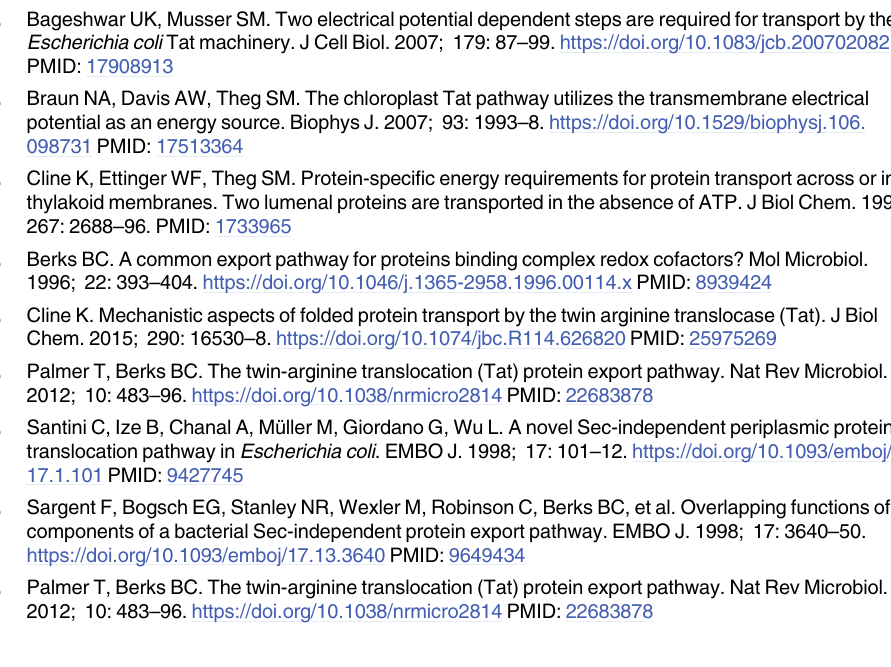
S1 Fig. Protein sequences for the purified proteins used in this study. The signal peptides of TorA and SufI are underlined, the TEV sequence is identified in blue , the QSV tag is identified in green , and other additions/linkers/mutations are indicated in red